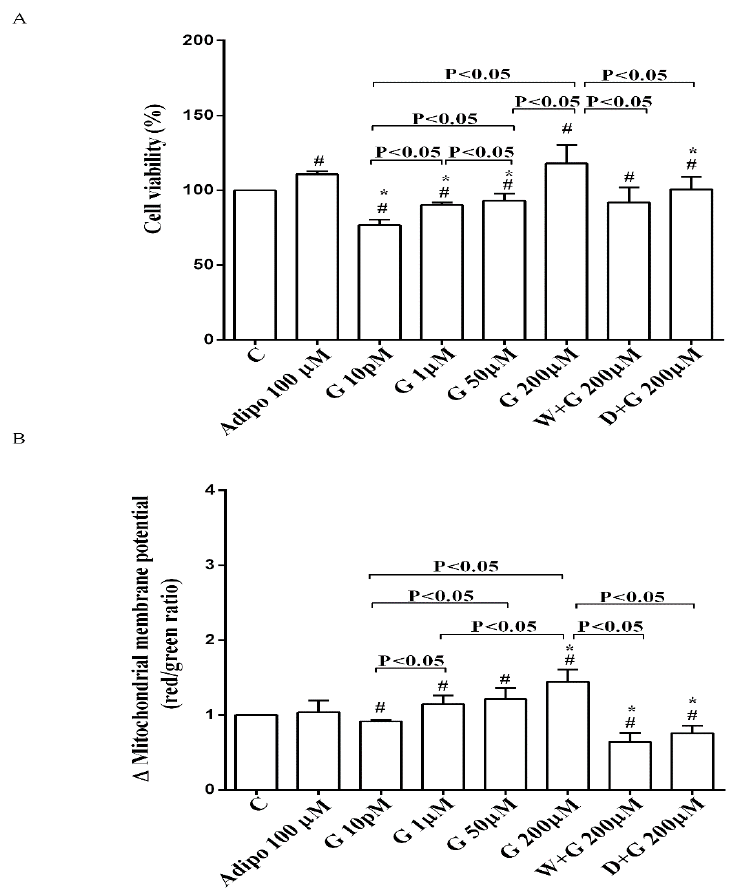
Figure 2. Effects of genistein in pre-adipocytes, cultured in physiological condition, on cell viability ( A ) and mitochondrial membrane potential ( B ): In A and B, the effects of genistein (G) 10 pM, 1 µ M, 50 µ M and 200 µ M, adiponectin (Adipo; 100 µ M), wortmannin (W; 200 µ M), dorsomorphin (D; 200 µ M). C = control. Reported data are means ± SD of five independent experiments for each experimental protocol executed in adipocytes taken from each patient. Significance between groups: # p < 0.05 vs. control; * p < 0.05 vs. Adipo 100 µ M. Short square brackets indicate significance between groups ( p < 0.05).